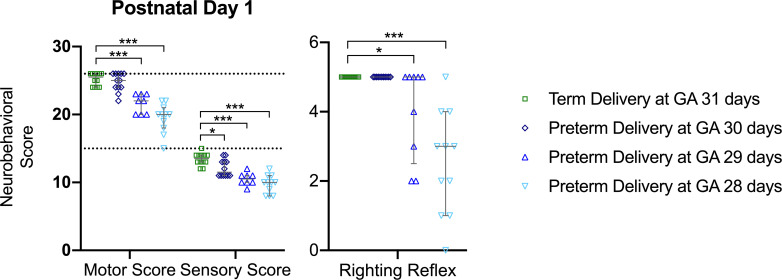
Neonatal rabbits’ neurobehavioral assessment on corrected postnatal day 1.Total neuromotor and neurosensory score (A) and righting reflex events (B). PCA31d n = 12, PCA30d n = 12, PCA29d n = 8 and PCA28d n = 11. Data displayed as median and IQR with significance compared to the term birth group indicated as * 0.05 ≥ p > 0.01; ** 0.01 ≥ p > 0.001; ***p < 0.001.